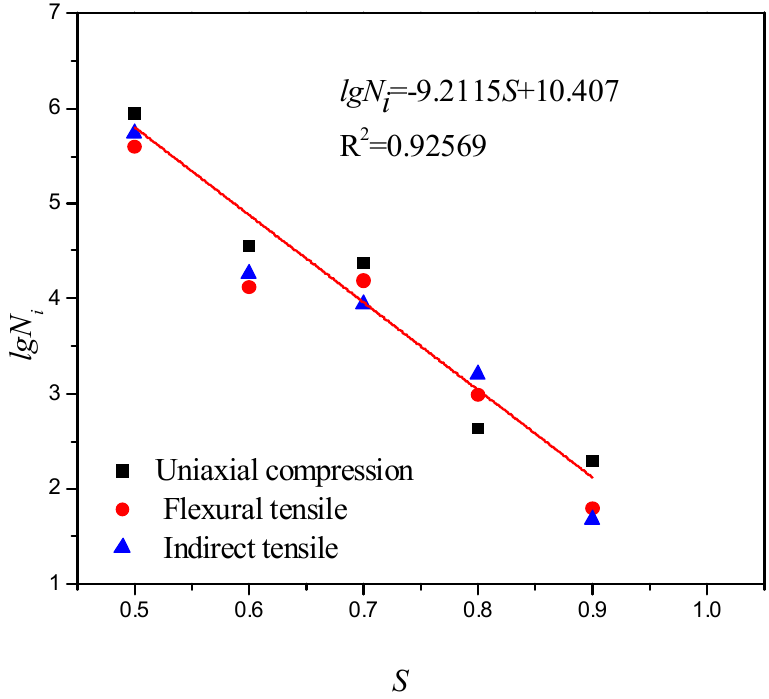
Figure 12. Standardization equations for the fatigue properties with a cement content of 3% at a curing time of 90 days and a guaranteed rate of 95% under different stress states.